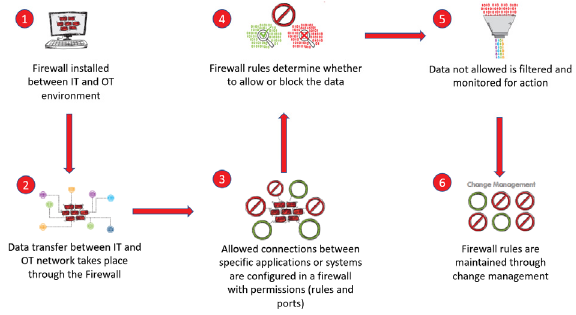
Figure 10. Network segmentation workflow.